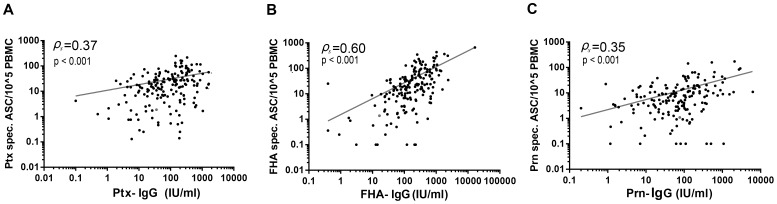
Spearman correlations between pertussis specific Bmem and corresponding IgG levels.Dots represent paired antigen specific Bmem cell frequencies and plasma IgG levels for Ptx (A), FHA (B) and Prn (C) for each participant.